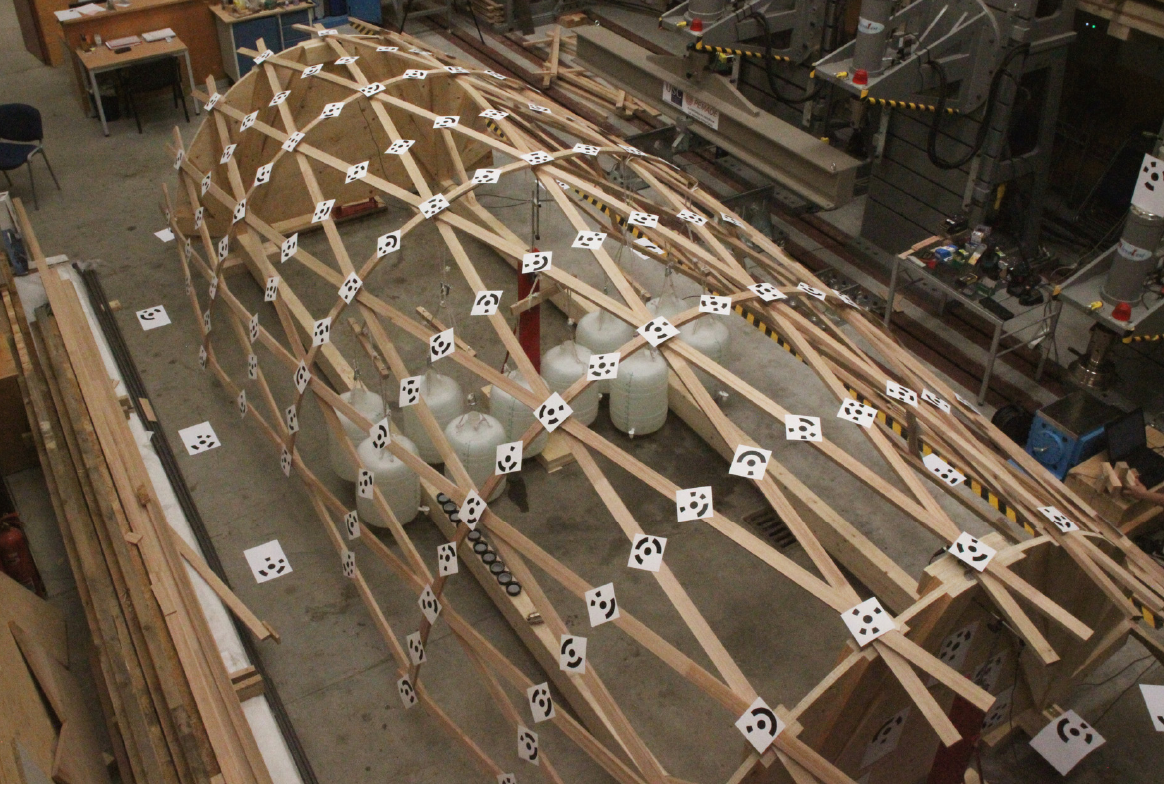
Figure 6. TEL-gridshell lab prototype view with the photogrammetric measuring target points.